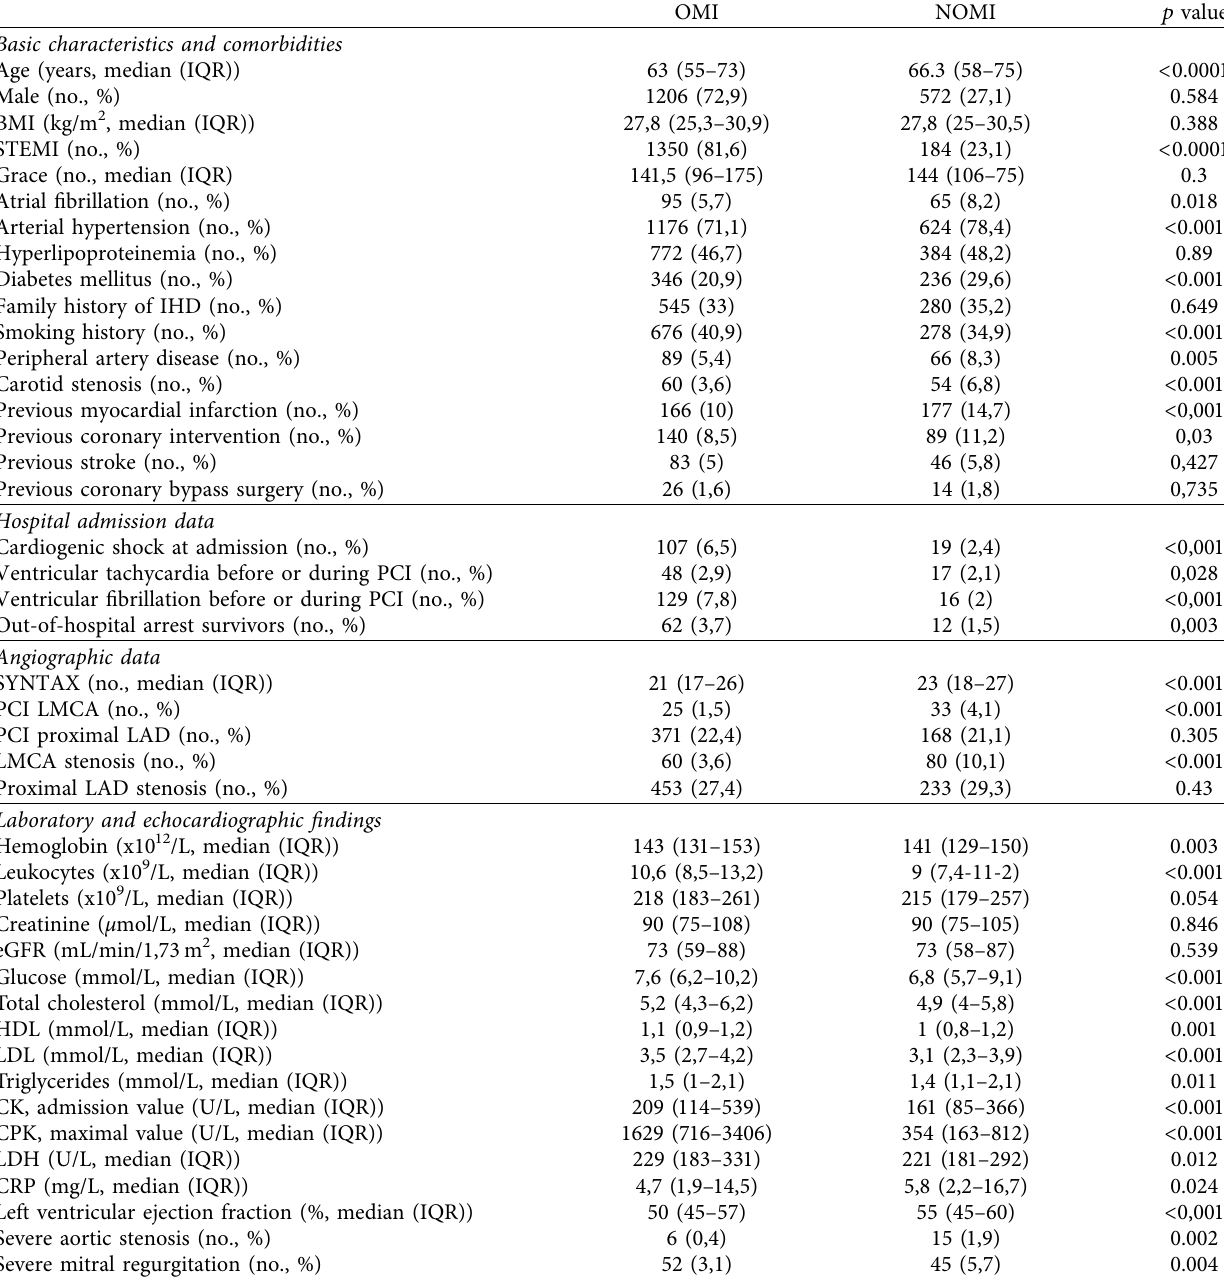
Table 1: Demographic, laboratory, echocardiographic, and angiographic data and procedural characteristics. OMI